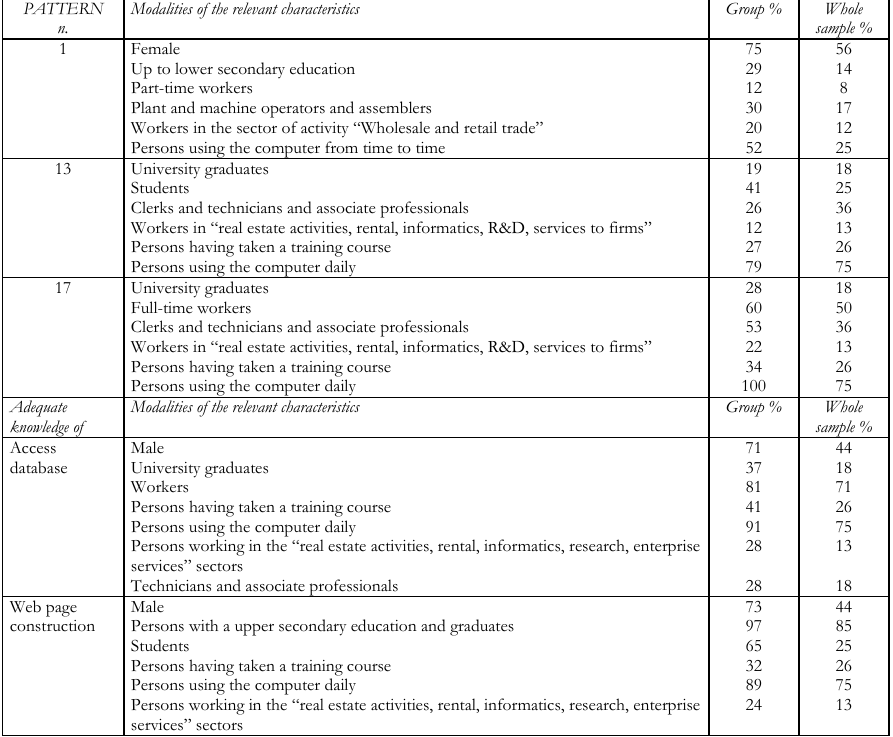
Features characterizing the most relevant patterns and different kinds of knowledge PATTERN